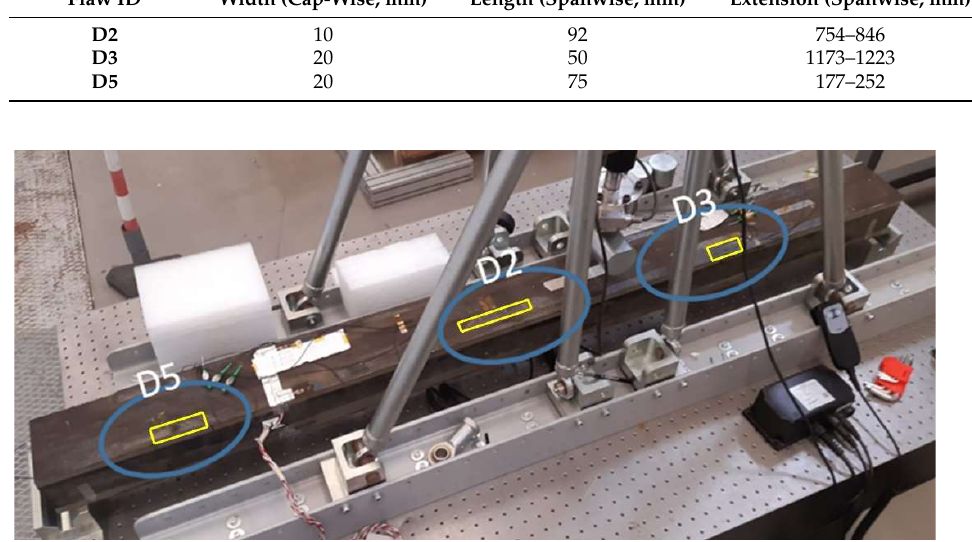
Figure 33. The composite beam with the indication of the implemented flaws.